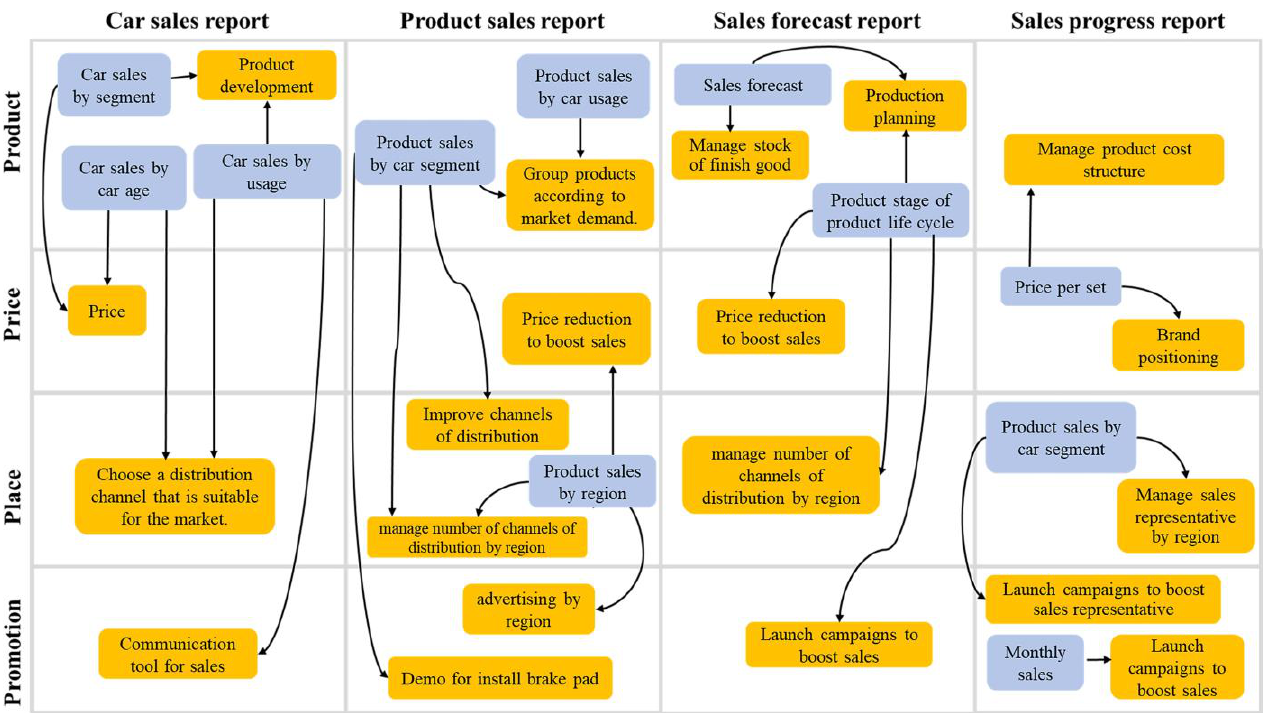
Figure 6. The framework of marketing mix strategy for intelligence.